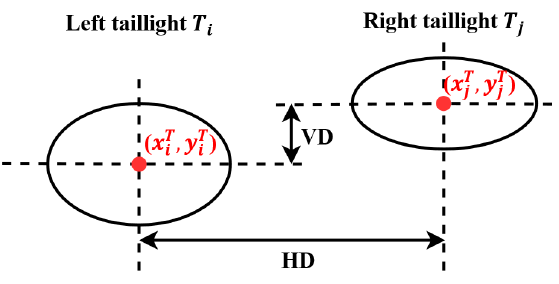
Figure 22. Horizontal distance (HD) and vertical distance (VD)